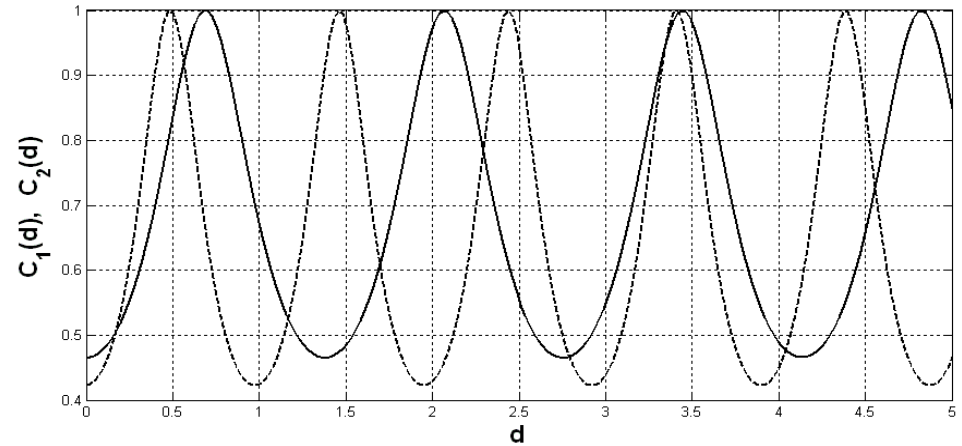
Figure 2. Two graphs of dependence of particle transmission coefficient on distance d between barriers. The solid line corresponds to the graph for a particle with a mass m = 2; the dotted line—to m = 5, E = 0.8, β = 4.